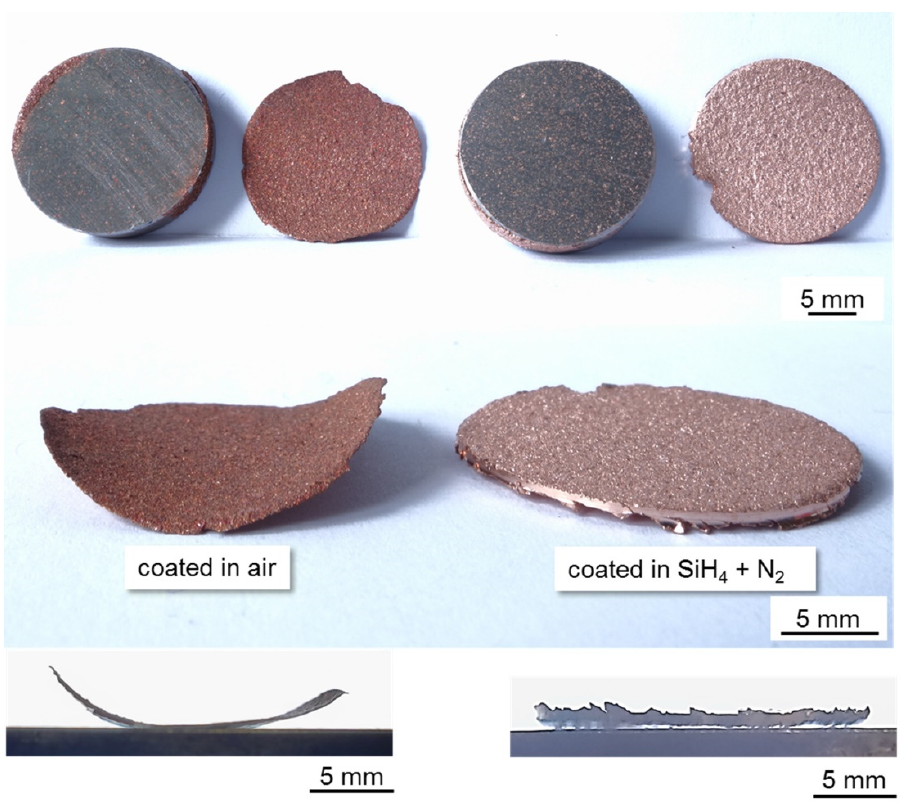
Figure 10. Optical images showing the substantial variation in the residual stress-induced curvature of the differently sprayed copper coatings.